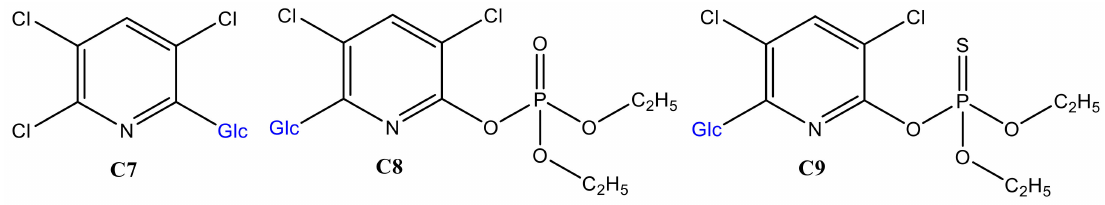
Figure 6. Proposed structures of CPF TPs glucosylation products in online